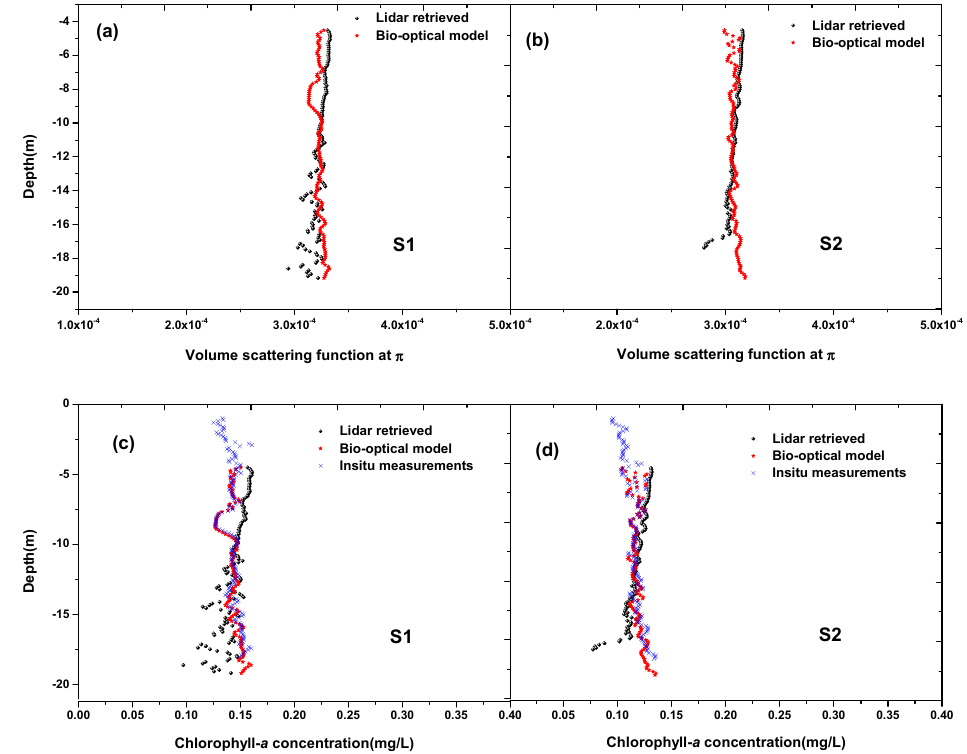
Figure 6. Comparison of airborne Lidar-retrieved β ( z ) and chlorophyll after using the Lidar calibration constant with the bio-optical model inversion results of in-situ measurements. ( a , c ) are for Station S1; ( b , d ) are for Station S2.